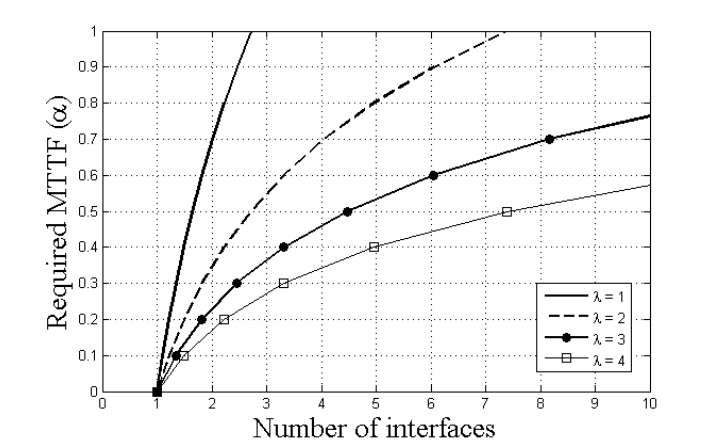
Figure 7. Number of interfaces required to ensure expected